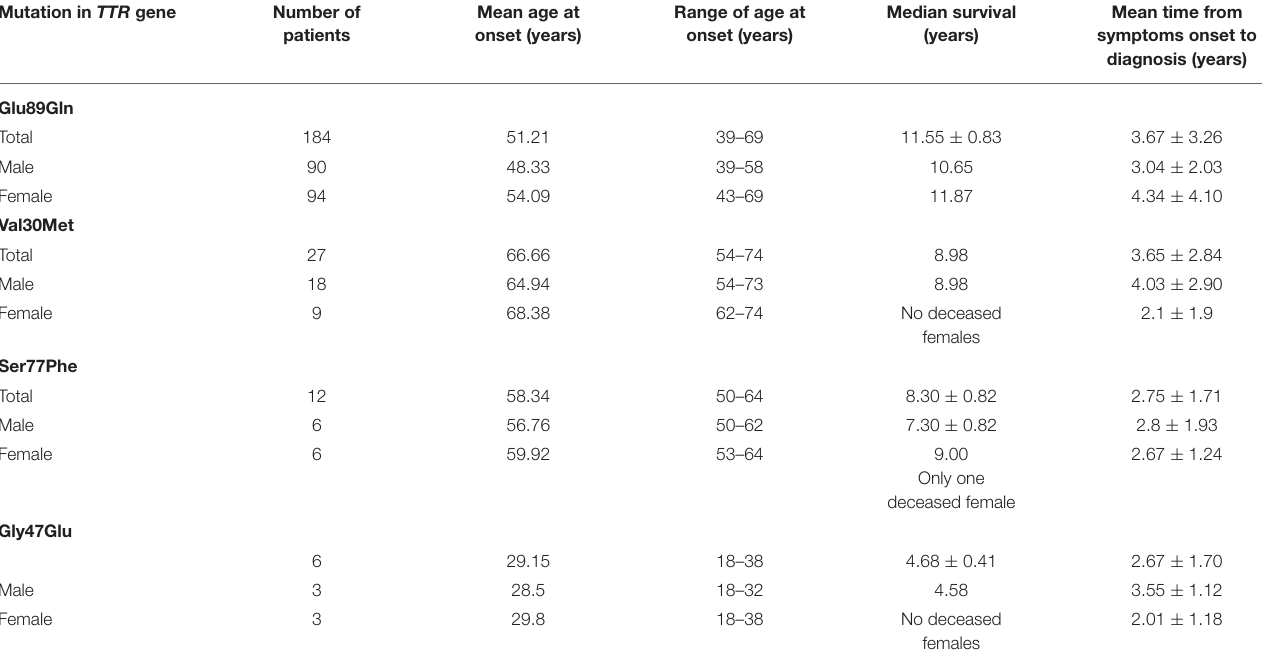
TABLE 1 | Epidemiological data of Bulgarian hereditary transthyretin amyloidosis (ATTRv) patients. Mutation in TTR gene